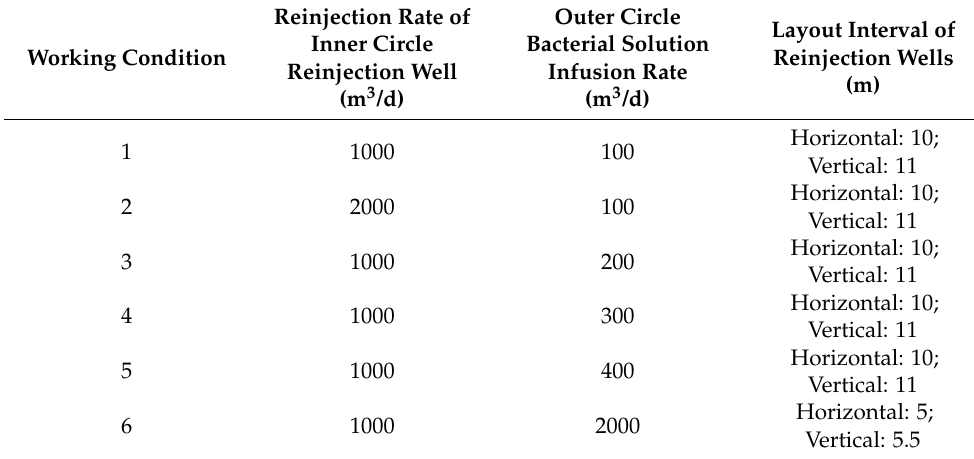
Table 6. Working condition of HSRB formed using MICP